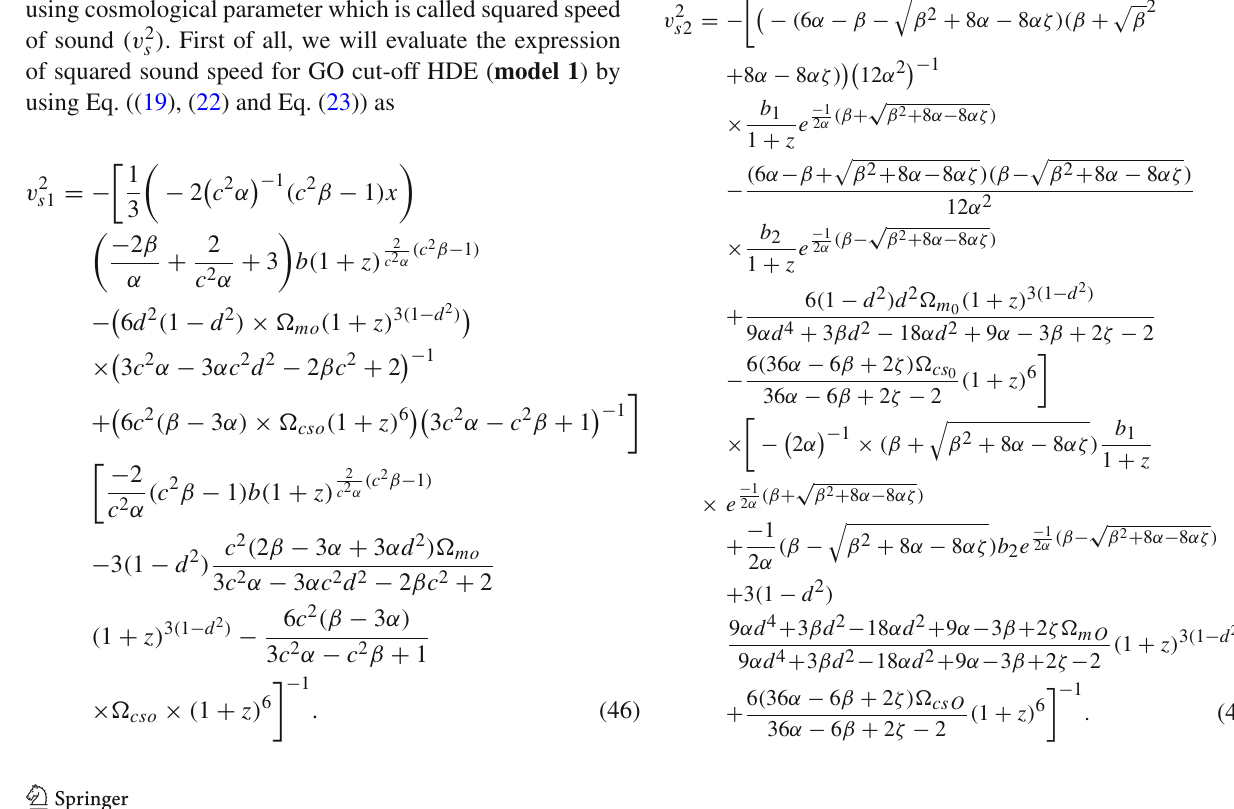
,v 2 and v 2 against redshift z s 1 s 2 s 3